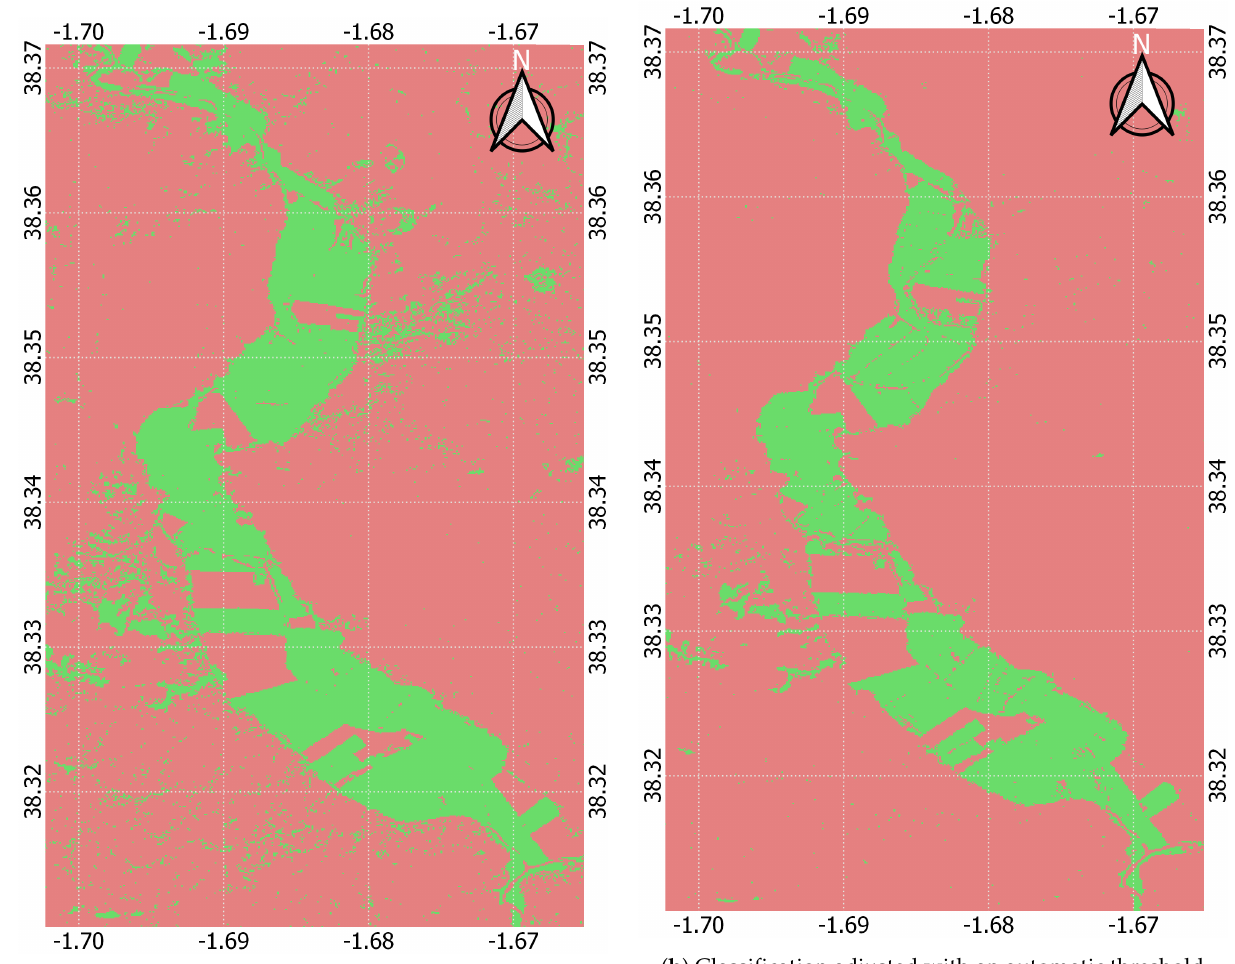
( b ) Classification adjusted with an automatic threshold (Green: Rice, Red: No Rice). Figure 9. Comparison between classification with a 50% threshold and adjusted with an automatic